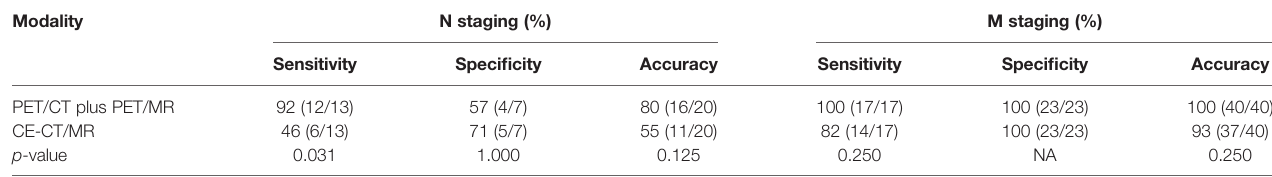
TABLE 3 | Diagnostic performance of PET/CT plus delayed PET/MR imaging and CE-CT/MR imaging in the assessment of N and M stages. Modality N staging (%) M staging